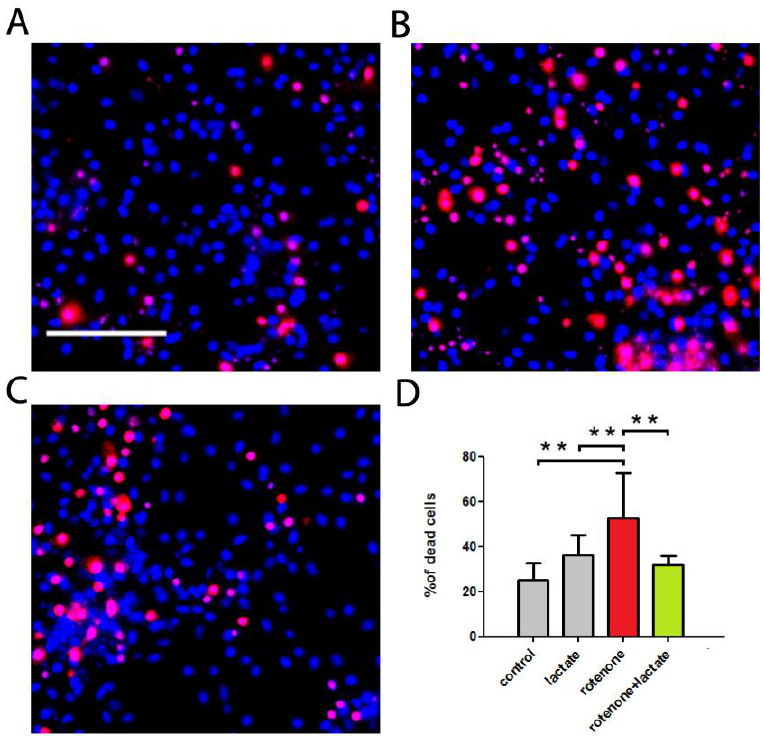
Figure 1. The effect of sodium lactate on rotenone-induced cell toxicity. Rotenone was added to the rat brain cell culture 36 h before measurements; 12 h after the addition of rotenone, sodium lactate was added. ( A – C ) Representative images of cells in primary cortical neuroglial culture stained with Hoechst 33342 (blue) and propidium iodide (red). ( A ) Control conditions ( B ) After 36 h of 1 mg/mL rotenone exposure ( С ) Rotenone in combination with 10 mM sodium lactate. Scale bar: 100 μm. ( D ) Percentage of nonviable cells, n = 3 experiments, ** p < 0.01.